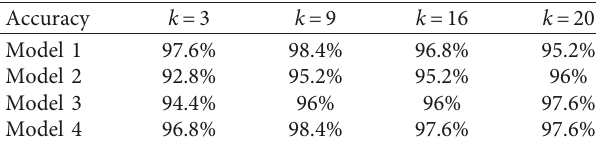
Table 2: Recognition accuracy for different values of k and per- centage error of broken wires is